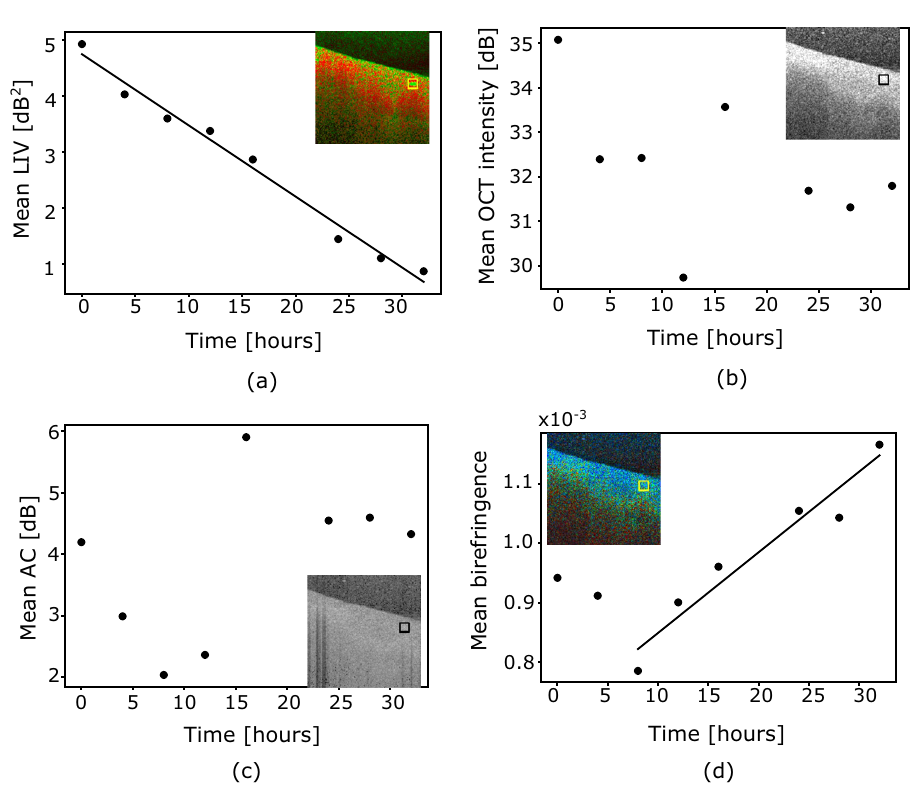
Figure 8. Time-course plots of the mean ( a ) LIV, ( b ) OCT intensity, ( c ) attenuation coefficient (AC), and ( d ) birefringence of the early fibrotic mouse liver. The mean values for each quantity are computed within the regions indicated by the square boxes in the insets of ( a – d